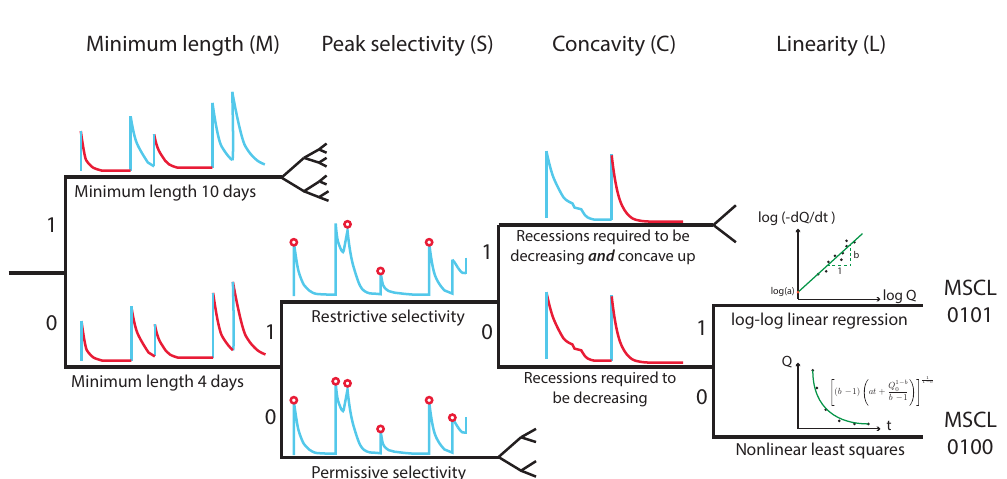
Figure 3. Graphical illustration of the 16 method choices. Minimum recession length ( M ) determines whether extracted recessions are required to have a minimum length of either 4 ( M = 0) or 10 days ( M = 1). Recession peak selectivity ( S ) determines whether the peak selection algorithm is highly restrictive ( S = 1) or relatively permissive ( S = 0). Recession concavity ( C ) determines whether recessions are required to be both decreasing and concave up ( C = 1), or simply decreasing ( C = 0). Finally, Linearity ( L ) determines whether or not the values of the recession parameters a and b are determined using linear regression on the plot of log [− d Q/ d t ] vs. log Q ( L = 1), or using a nonlinear least squares fit to the raw recession time series ( L =